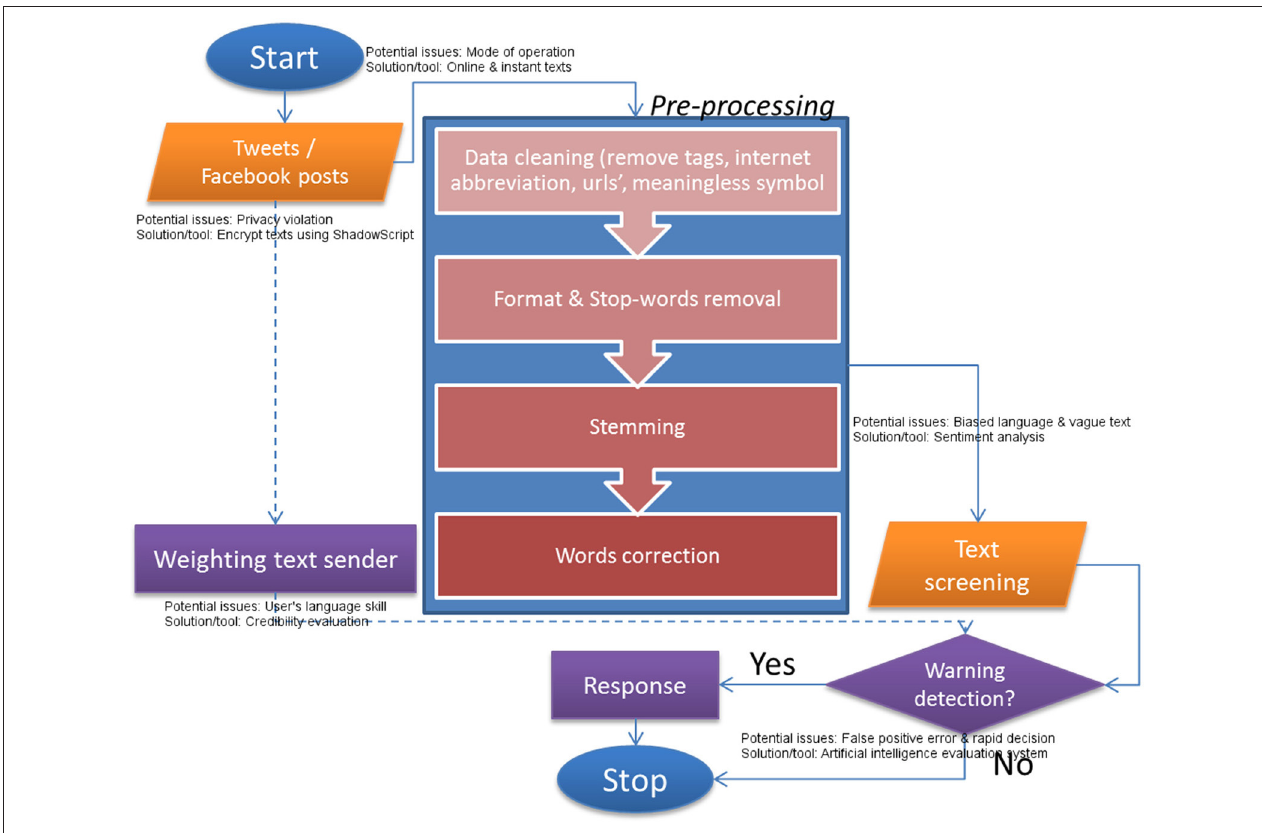
FIGURE 2 | A position of the proposed online text pre-processing steps in the passenger-participation warning